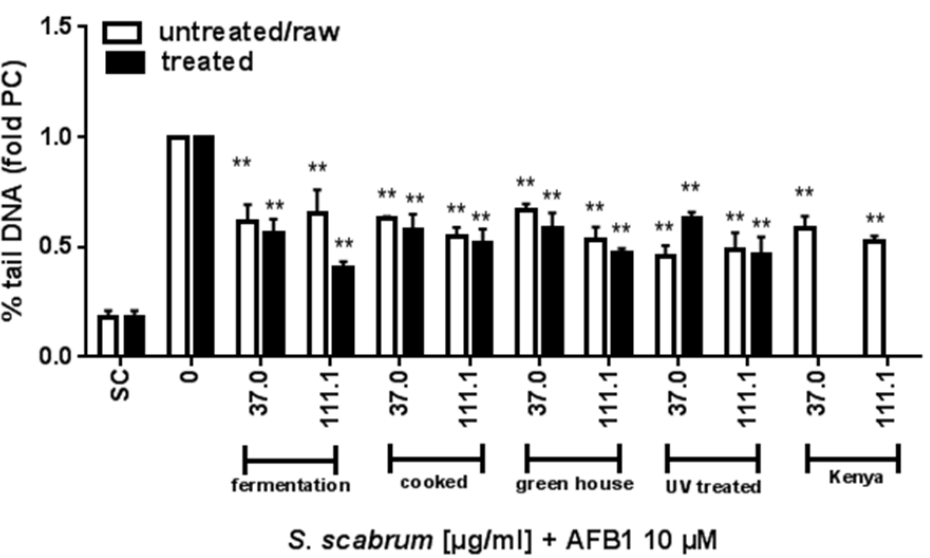
Figure 3. Impact of cultivation, processing and UV-C on the anti-genotoxic activity of S. scabrum against AFB 1 . Results derived from the Comet assay are shown as percent tail DNA calculated relative to AFB 1 -treated cells. SC: solvent control, 0.1% DMSO + 0.7% ethanol. Data are means ± SEM of three independent experiments. Asterisks indicate statistically significant differences between the respective treatment and the positive control (without S. scabrum leaf extract) p ≤ 0.01 (**).